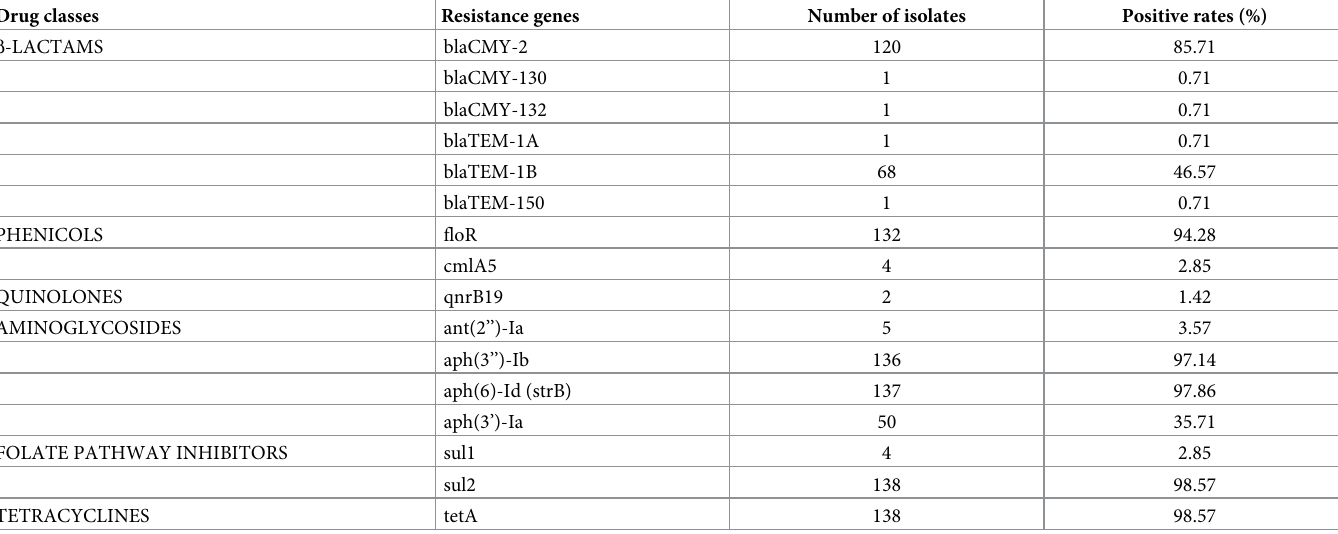
Table 2. Antimicrobial resistance genes of 140 Salmonella Dublin isolated from cattle. Drug